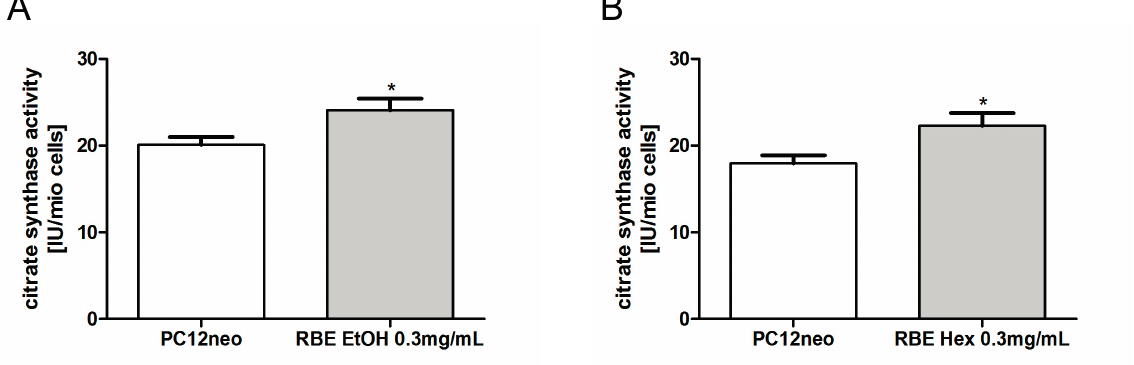
Figure 6. Mitochondrial content marker citrate synthase (CS) activity was significantly increased after 24-h incubation of PC12 cells with ethanolic (RBE EtOH, ( A )) or hexanic (RBE Hex, ( B )) rice bran extract (RBE); n = 8–12; mean ± SEM; ANOVA with Tukey’s post- test; * p <